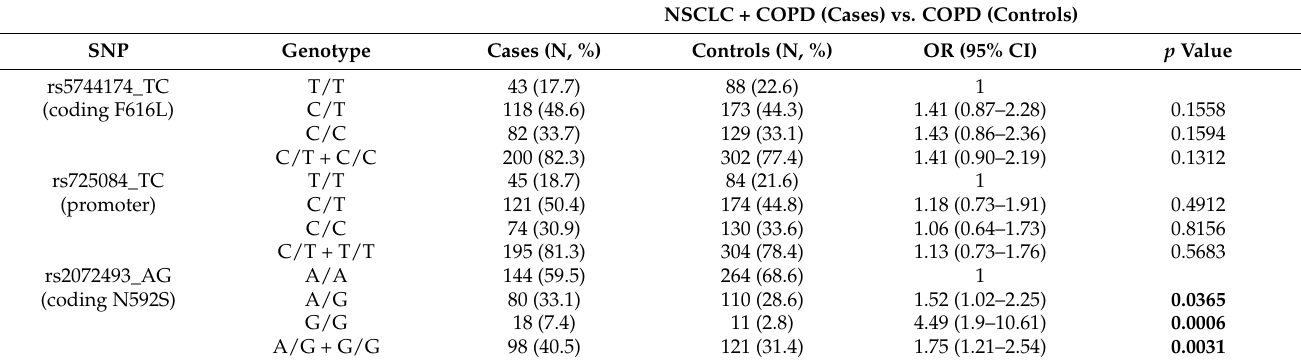
Table 5. Association of selected TLR5 SNPs with non-small cell lung cancer (NSCLC) development in the cohort of patients co-diagnosed with